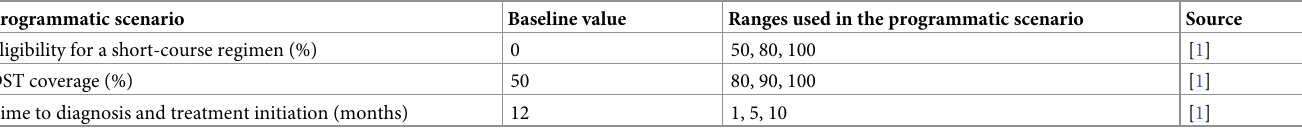
Table 2. Programmatic scenarios used in the model projections along with the evaluation of short-course MDR-TB regimens. Programmatic scenario